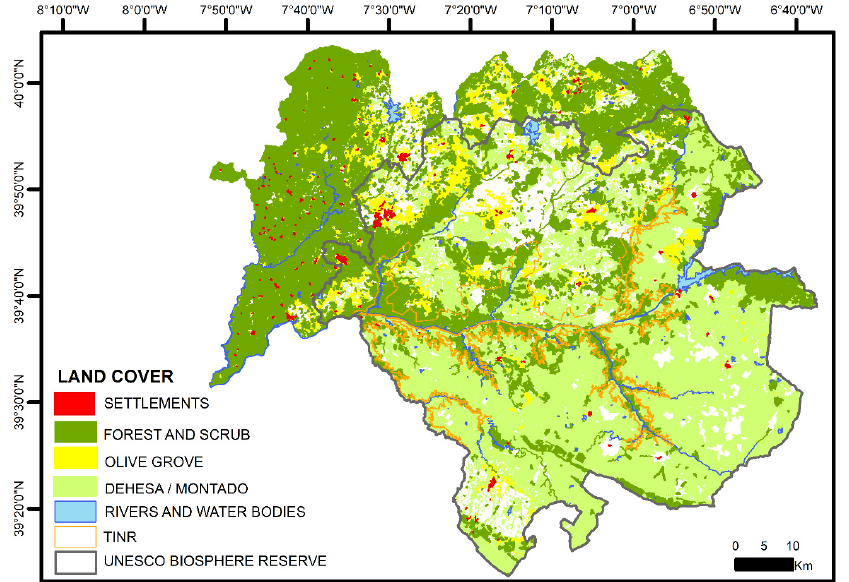
Figure 2. Main land uses of soil in study area. Source : Authors’ own elaboration based on COS and SIOSE data.